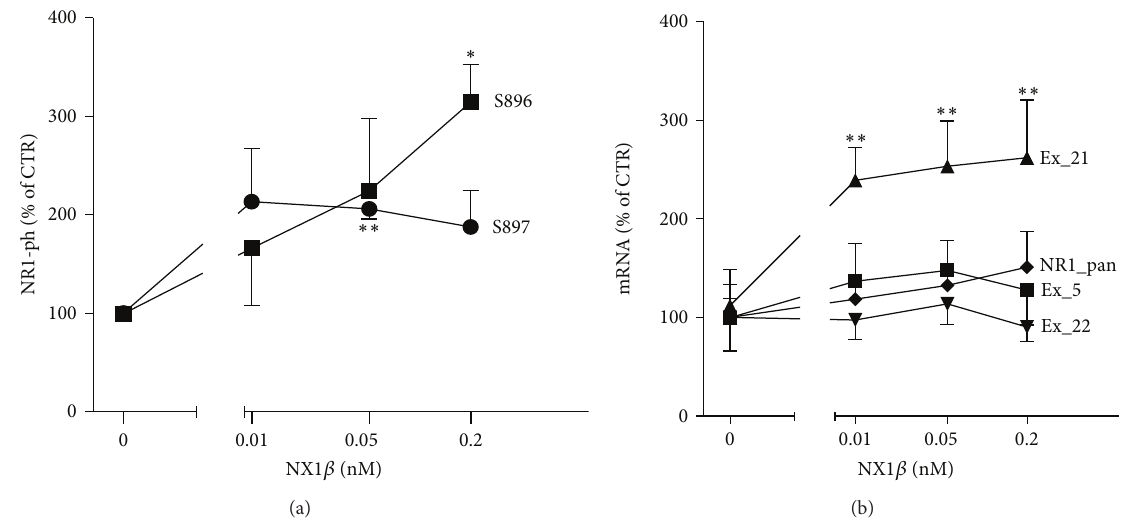
Figure 5: NX1 𝛽 differentially affects the phosphorylation and expression of NR1. (a) Cortical neurons were grown for 8 days, subsequently treated with different concentrations of recombinant NX1 𝛽 for 5 min, and further immunoblotted for the detection of NR1 phosphorylation at S896 and S897. Representative immunoblots of three to four individual experiments are shown. The results from 𝑛 ≥ 4 experiments are expressed as a percentage ± SEM. ∗ 𝑃 < 0.05 , compared with the untreated control set at 100%. (b) Cortical neurons were grown for 8 days and treated with different concentrations of recombinant NX1 𝛽 for 48 h. Total RNA was isolated, and mRNA levels were assessed using RT-PCR. The results from 𝑛 = 5 experiments are expressed as a percentage ± SEM. ∗ 𝑃 < 0.05 , compared with the untreated control set at